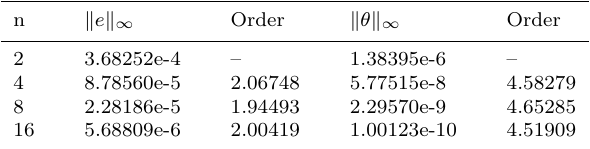
Table 7. Numerical results for example 4.